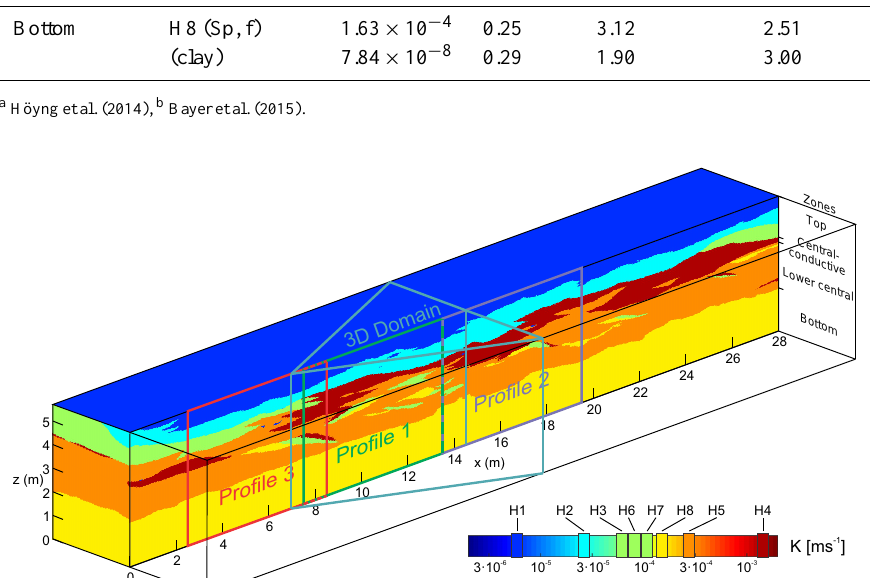
Figure 3. Vertical cross section through the center of the 3-D Descalvado analog data set showing the distribution of hydraulic conductiv- ity ( K ). H1–8 represent the hydrofacies units (ignoring clay intraclasts). The location of the three 2-D and one 3-D profile is marked with different